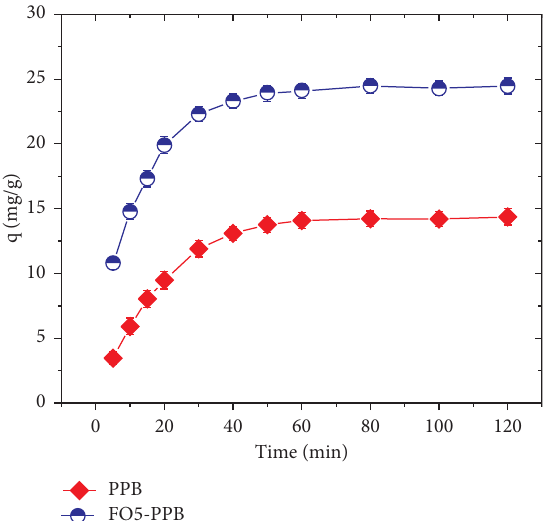
Figure 8: The effects of temperature on RR21 adsorption onto PPB and FO5-PPB. Experimental conditions: pH: 3; initial concentra- tion: 50mg/L; adsorbent dose: 2 g/L; contact time: 60